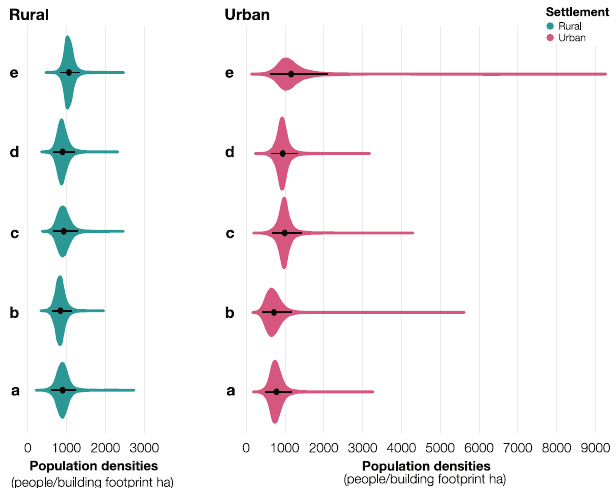
Fig. 3 Model intercepts. Posterior probability distributions of the random intercepts (people/building footprint ha) by settlement type (urban in pink and rural cluster in turquoise) across the provinces of ( a ) Kinshasa, ( b ) Kongo Central, ( c ) Kwango, ( d ) Kwilu, and ( e ) Mai-Ndombe. The black dots show the mean of the distributions and the horizontal black lines show the 95% credible intervals derived from the posterior distribution ( n = 10,000). Source data are provided with this paper.